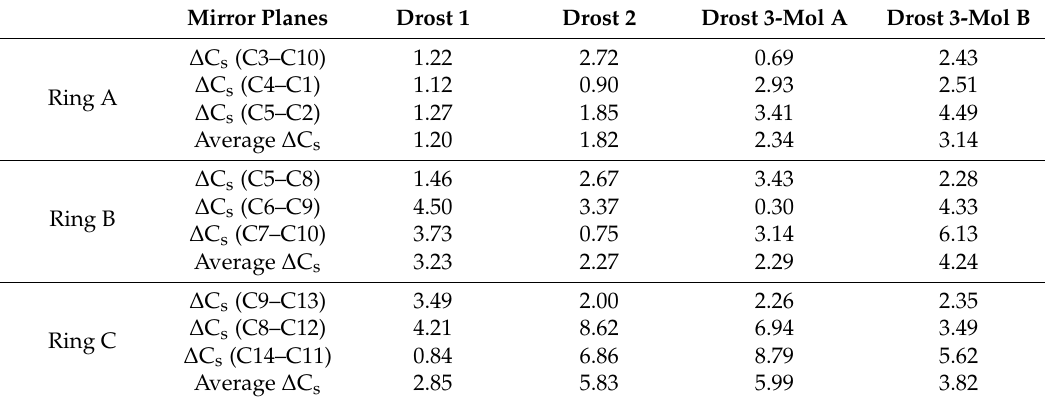
Table 7. Calculated asymmetry parameter values in studied compounds.